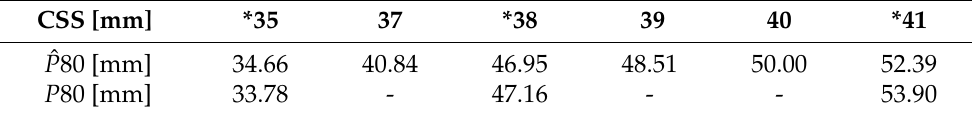
Table 8. P 80 values in Scenario